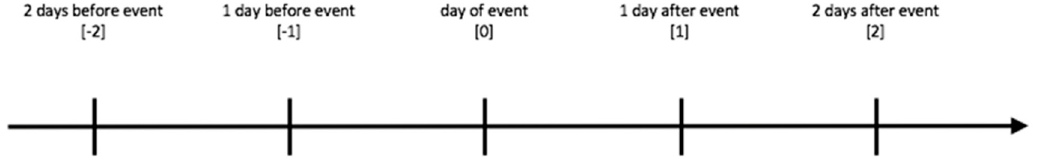
Figure 1. Time window of the event study. Source: own representation based on (McWilliams et al. 1999).